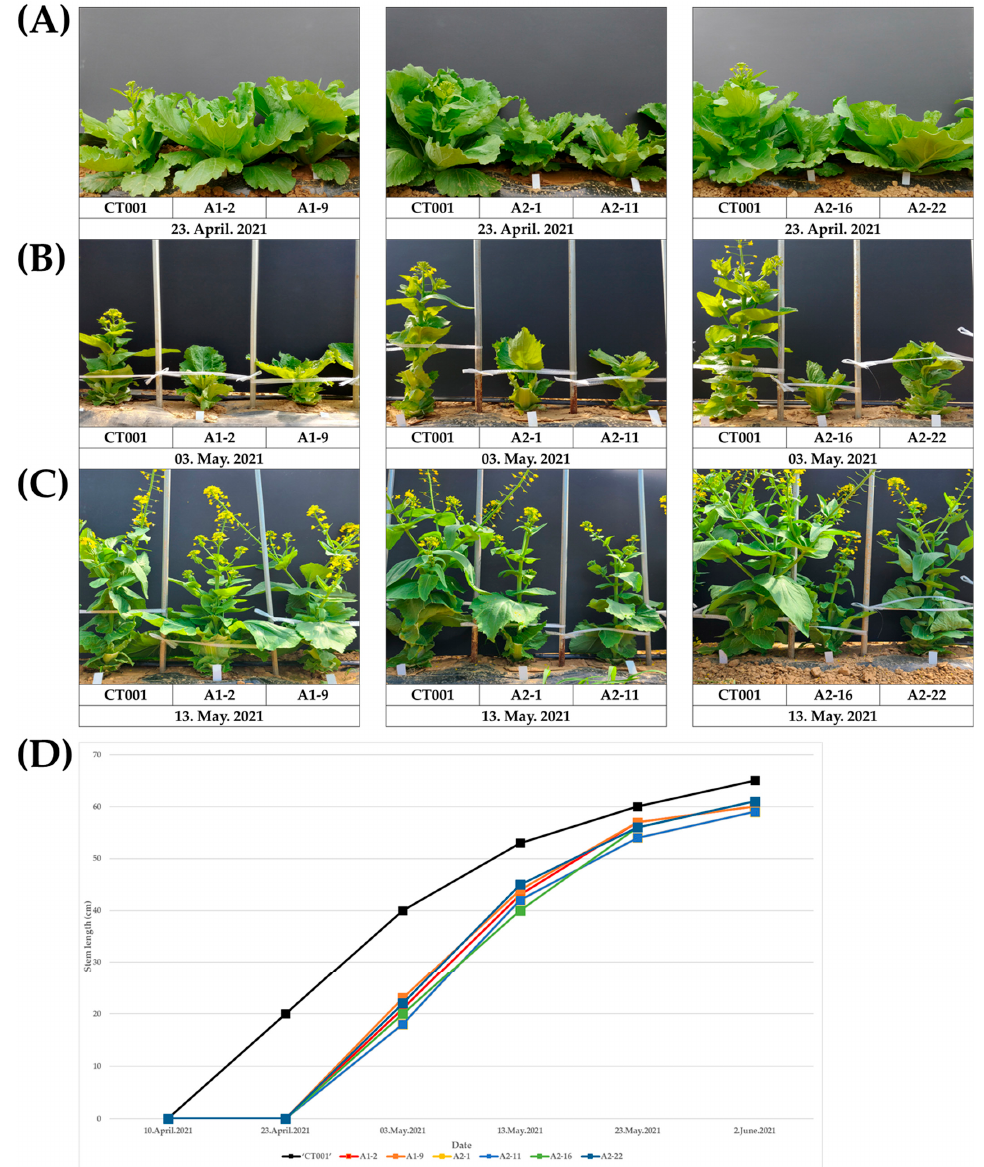
Figure 3. Observation of bolting time and stem length of inbred line ‘CT001 ′ and E 0 AGL -edited lines. ( A ) Beginning stage of bolting. ( B ) Early stage of bolting. ( C ) Middle stage of bolting. Left, inbred line ‘CT001 (cid:48) ; middle and right, E 0 AGAMOUS-like (AGL) -edited lines. ( D ) Stem length of inbred line ‘CT001 (cid:48) and E 0 AGL -edited lines. Stem length gained from beginning to end of bolting in each line. The stem length was measured from the ground to the shoot apex.